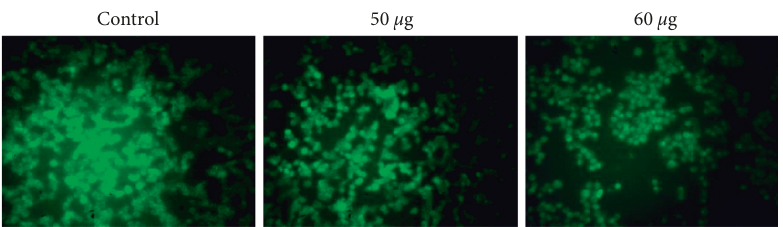
Figure 9: Staining of mitochondria using Rh-123 in human MOLT-4 cells treated with ZnO-TiO